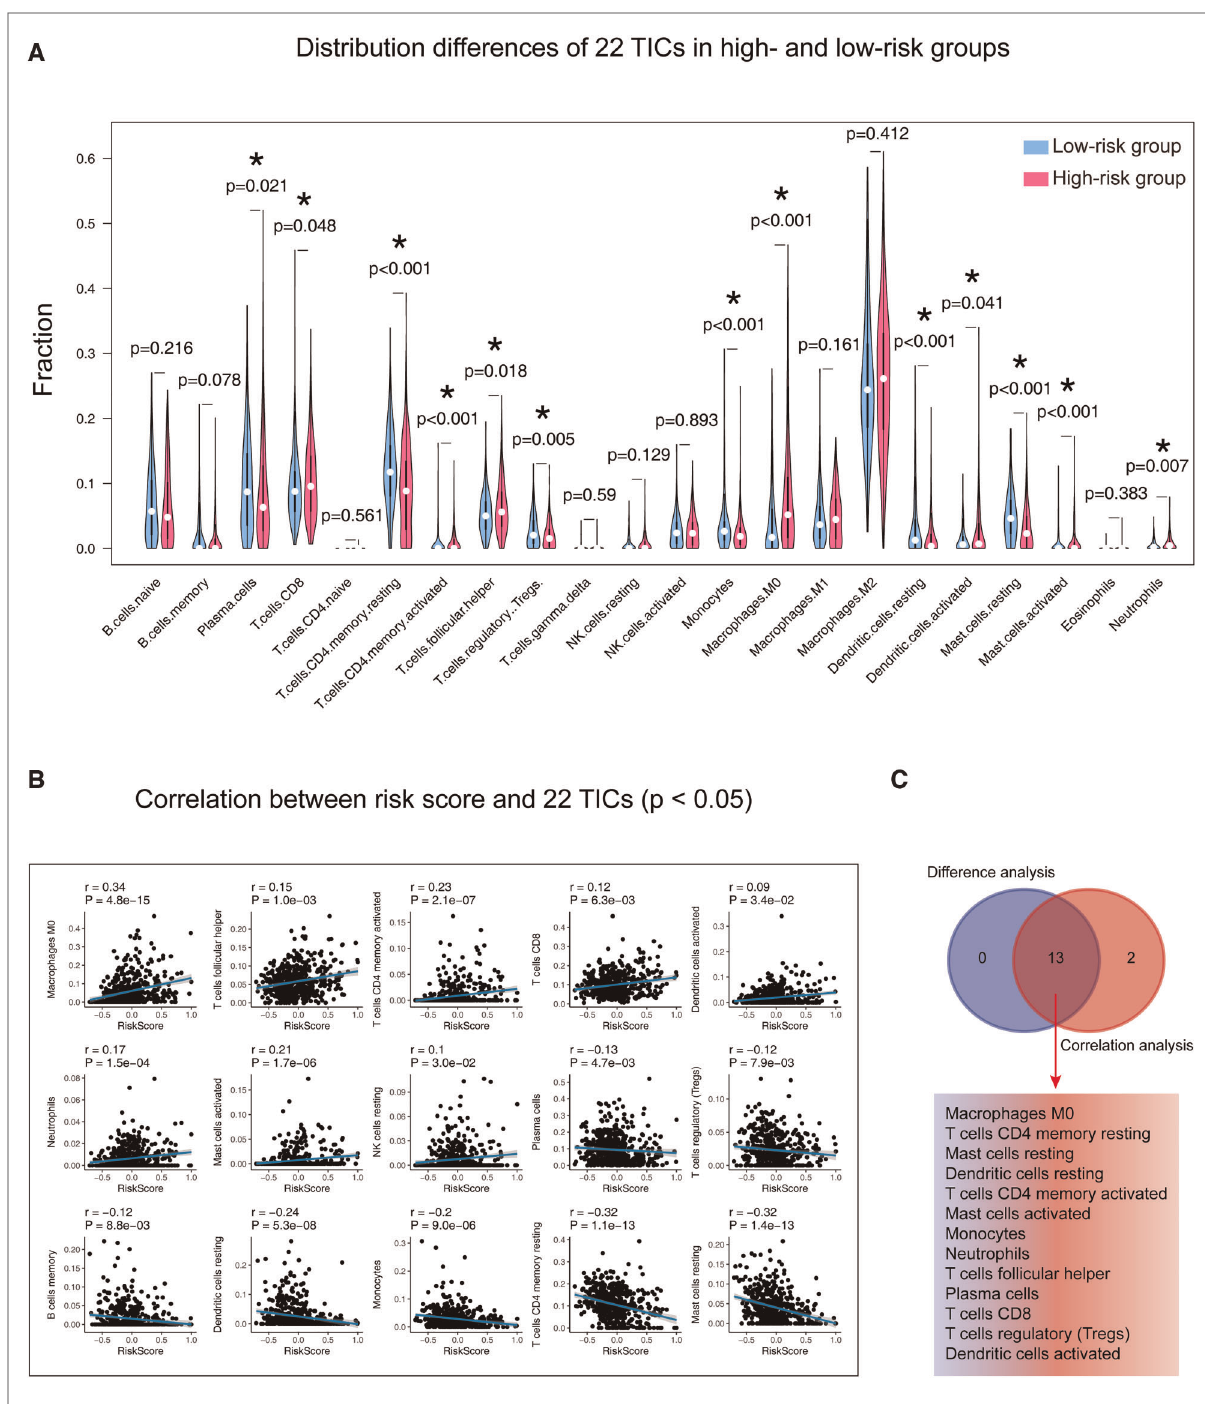
FIGURE 7 Determination of the relationship between the 22 TICs and our signature. ( A ) Patients were divided into high and low-risk groups according to their median risk score, and the Wilcoxon rank-sum was applied to detect differences in TIC distribution between different groups. ( B ) Spearman ’ s coef fi cient assessed the correlations between the 22 TICs and our model. Here, we plotted the TIC correlation with a p -value<0.05. ( C ) The results of Wilcoxon ’ s rank-sum test and Spearman ’ s coef fi cient were intersected to determine stable and critical TICs. TIC, tumor-in fi ltrating immune cell; *: p -value<0.05; p -value<0.05 is considered signi fi